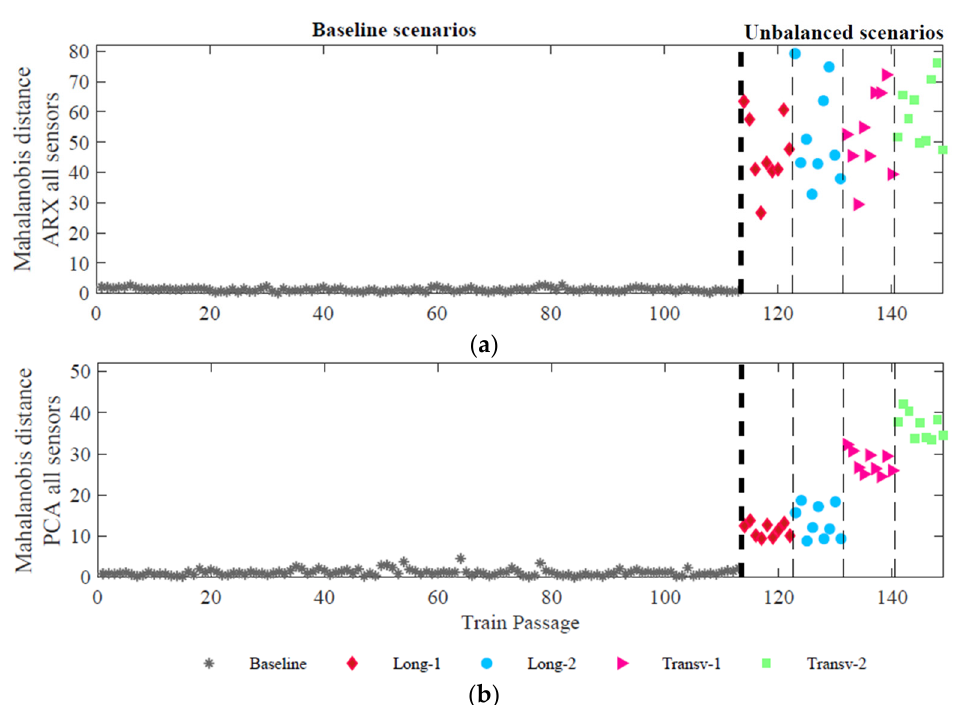
Figure 14. Data fusion 3rd level—merging of all sensors (strains and accelerations) ( a ) ARX features ( b ) PCA features.